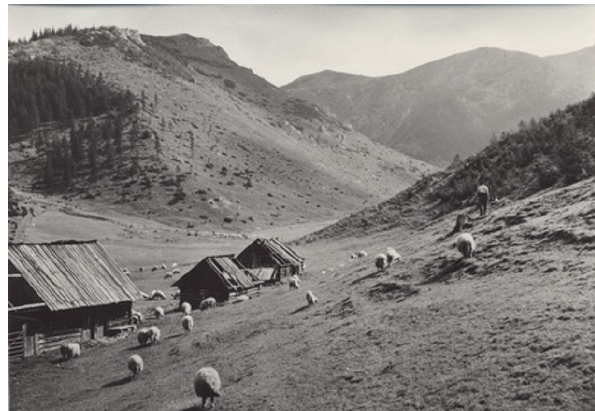
Figure 2. Sheep grazing in Jaworzynka Valley; shepherds’ huts are visible (photo archive – Tatra Documentation Center, Tatra National Park, Zakopane, Poland).